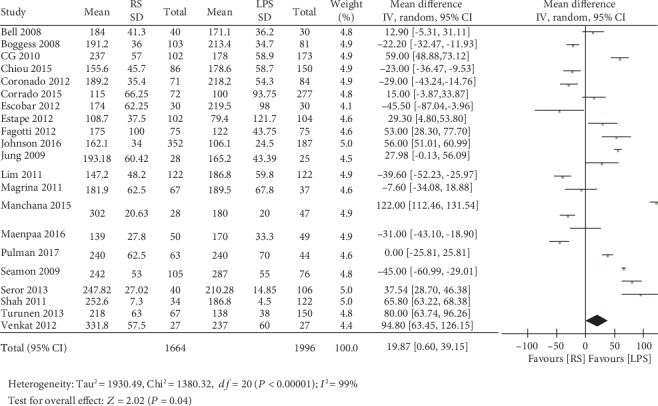
Forest plot of the OT between the RS and LPS groups.